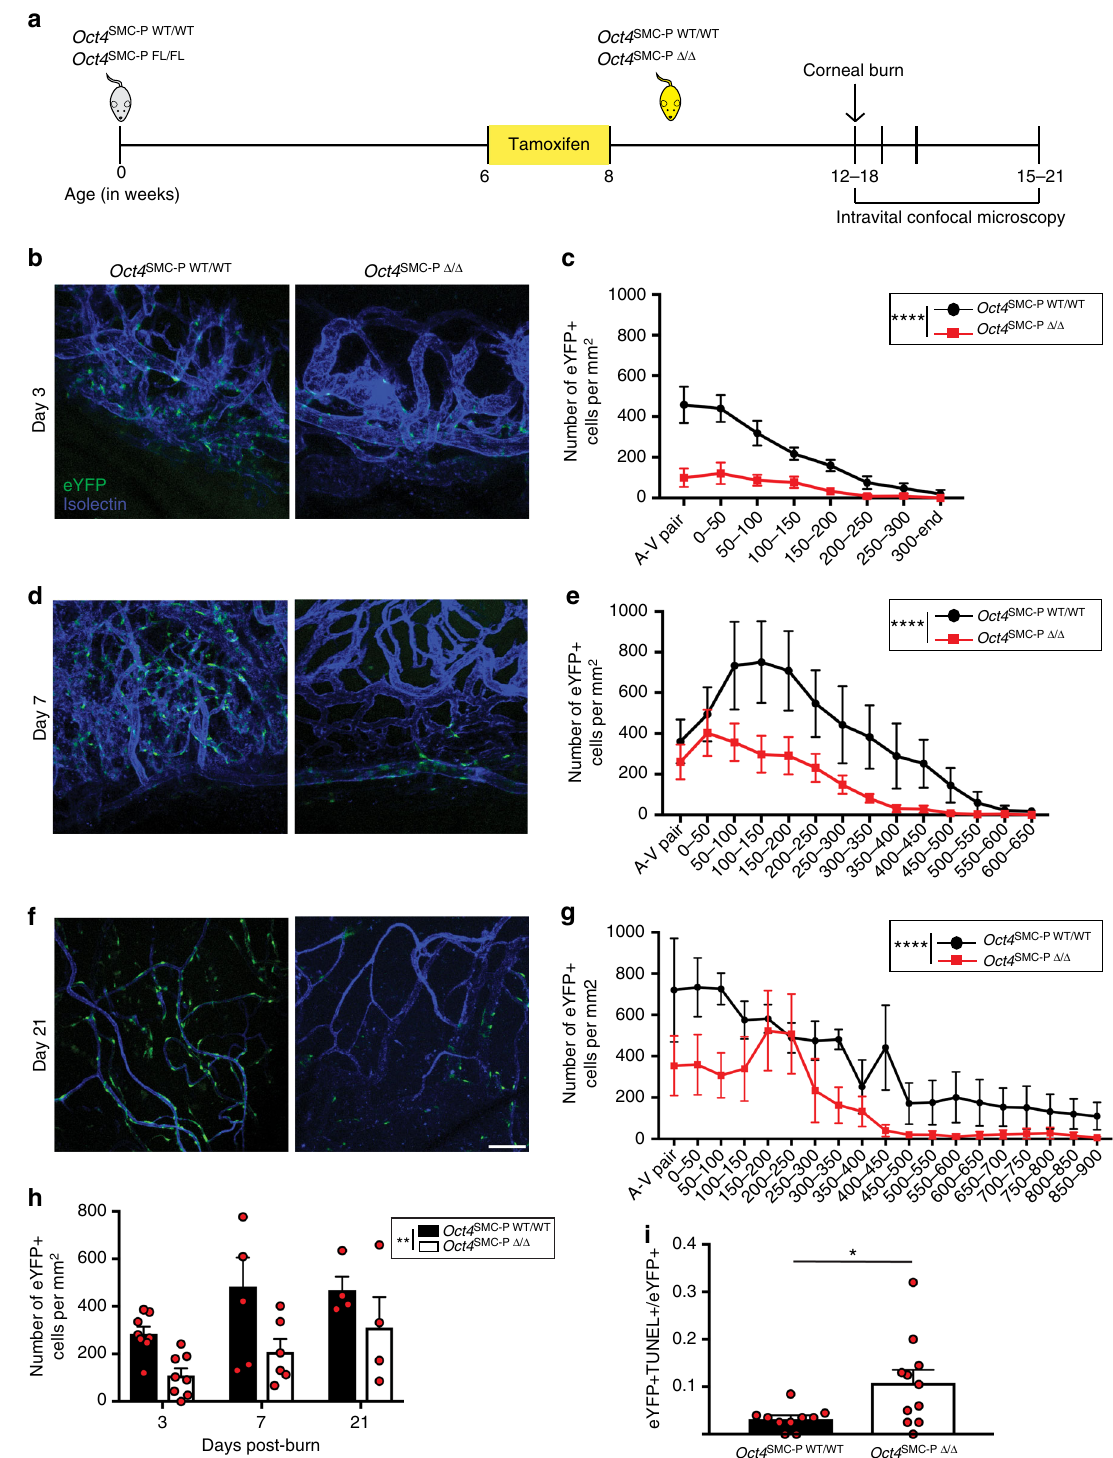
Fig. 3 SMC-P conditional knockout of Oct4 resulted in impaired migration and increased cell death of eYFP + cells following corneal burn. a Schematic outlining experimental design. b – g Representative intravital confocal microscopy images for native eYFP (green) and perfused isolectin (blue) and quanti fi cation of the number of eYFP + cells per area at days 3 ( b , c ), 7 ( d , e ), and 21 ( f , g ) post-corneal burn. Scale bar = 50 μ m [ n = 8 WT, 8 KO ( c ); n = 6 WT, 6 KO ( e ); n = 4 WT, 4 KO ( g )]. h Quanti fi cation of the number of eYFP + cells throughout the entire network area at days 3, 7, and 21 post-burn. i Quanti fi cation of the ratio of TUNEL + eYFP + cells to total eYFP + cells in cornea vasculature at day 1 ( n = 10 WT, 11 KO) post-burn. Values = mean ± s.e. m. Statistics were performed using unpaired two-tailed t -test ( i ) or two-way ANOVA ( c , e , g , h ). * P < 0.05, ** P < 0.01, **** P <